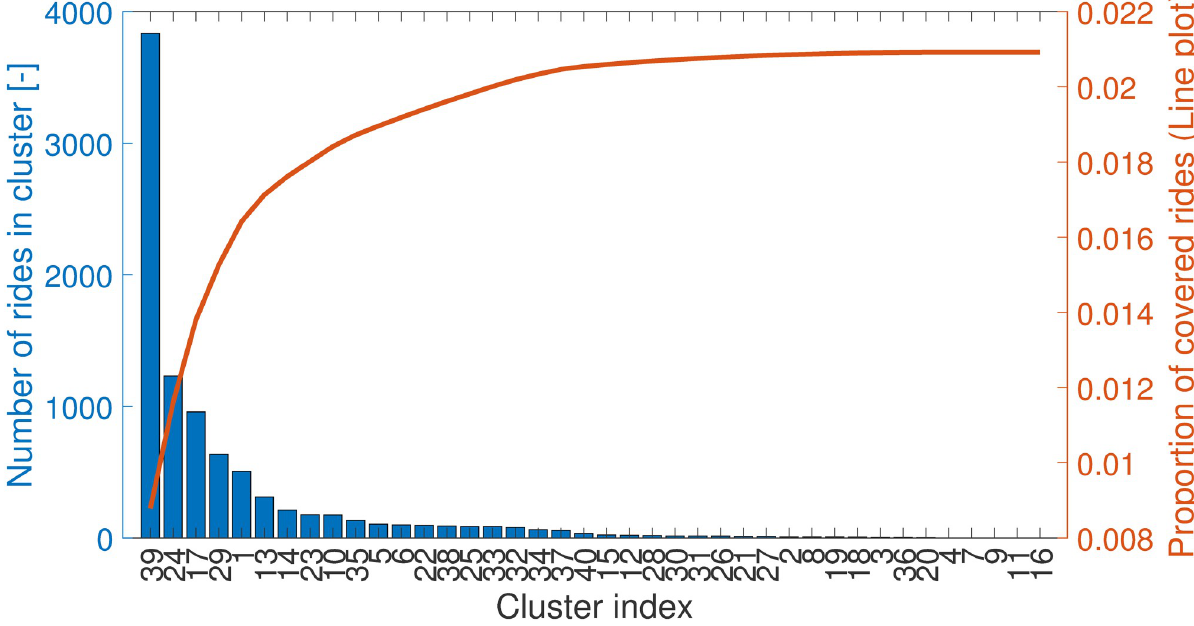
Fig 4. The number of data points in each cluster if the threshold of membership is P covered by the clusters compared to all the analysed Taxicab rides during the nights (line plot, right axis). Some clusters have low importance due to the few supporting passengers (bar plots in part (b)). As the Taxicab rides usually handle unique and occasional travels, a small percentage of the rides can be replaced by public transportation